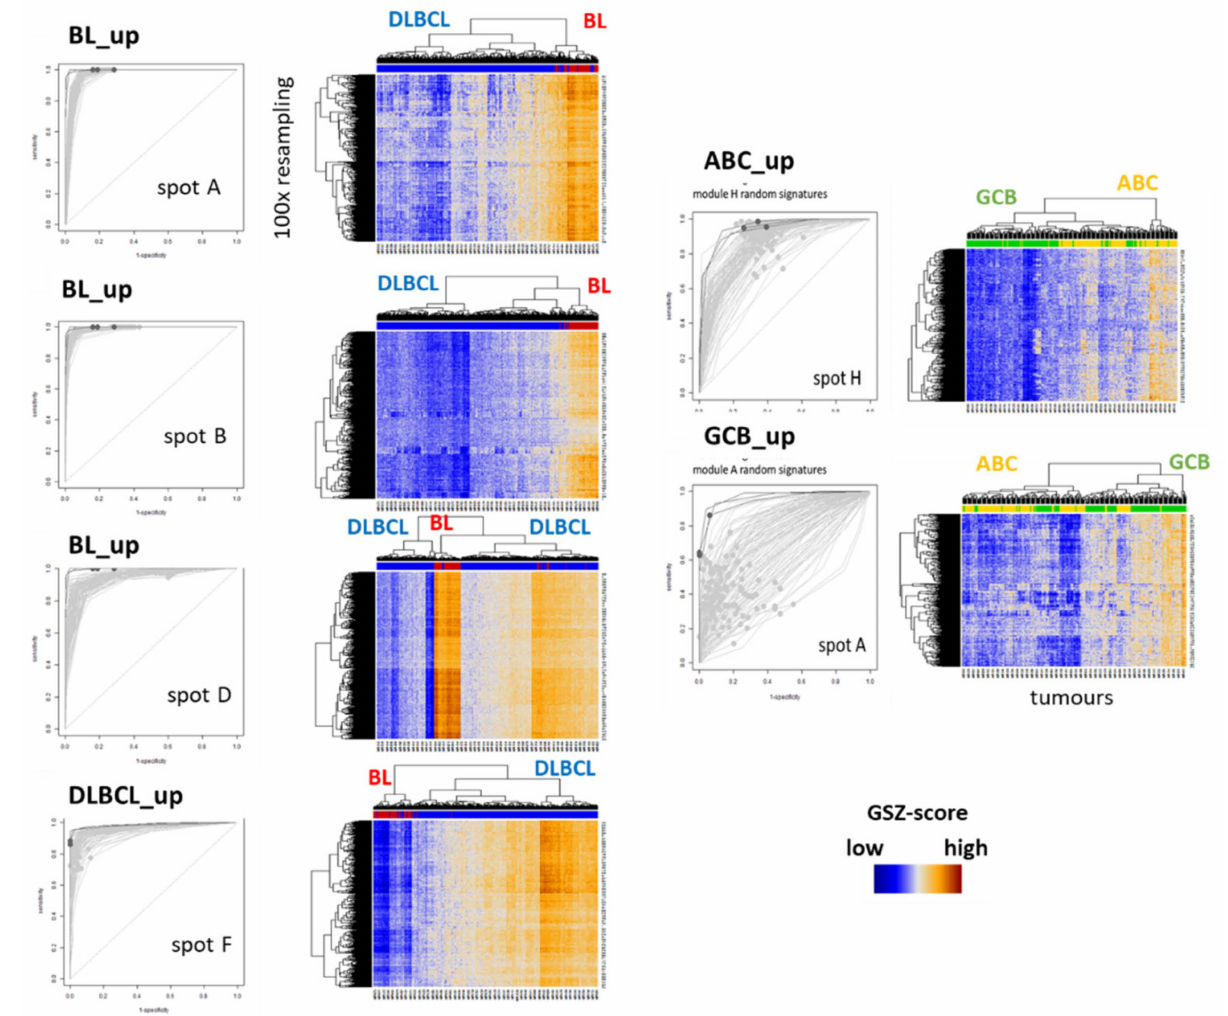
Figure A10. Classification of lymphoma subtypes using randomly sampled genes from the spots: For each spot module, 20% of genes were sampled randomly (100 × resampling) and used as expression signature for classifying BL versus DLBCL (left part) and ABC versus GCB DLBCL (right part). The figure shows the ROC curves as well as two-way clustered GSZ heatmaps. AUC values were shown in Figure 7e. Spot B best separates BL versus DLBCL (BL-up signature) virtually independent of the selected genes. Spot D (proliferation) performs (BL-up) worse because also part of DLBCL show increased GSZ-values. The ABC-versus-GCB classification (right part), especially GCB_up (spot A), shows large variability of classification power. ROC curves were obtained by shifting the classification threshold from minimum to maximum GSZ-values. The dots along the curves refer to a threshold at GSZ =